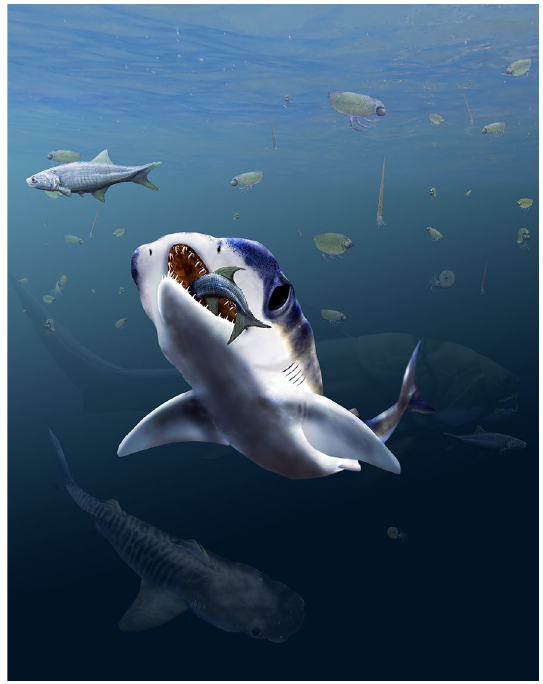
Fig. 15 Reconstruction of Maghriboselache mohamezanei n. gen. et sp. in its habitat. Thylacocephalans, cephalopods with orthoconic conchs, placoderms such as Dunkleosteus and osteichthyans populated the water column during the middle Famennian in the